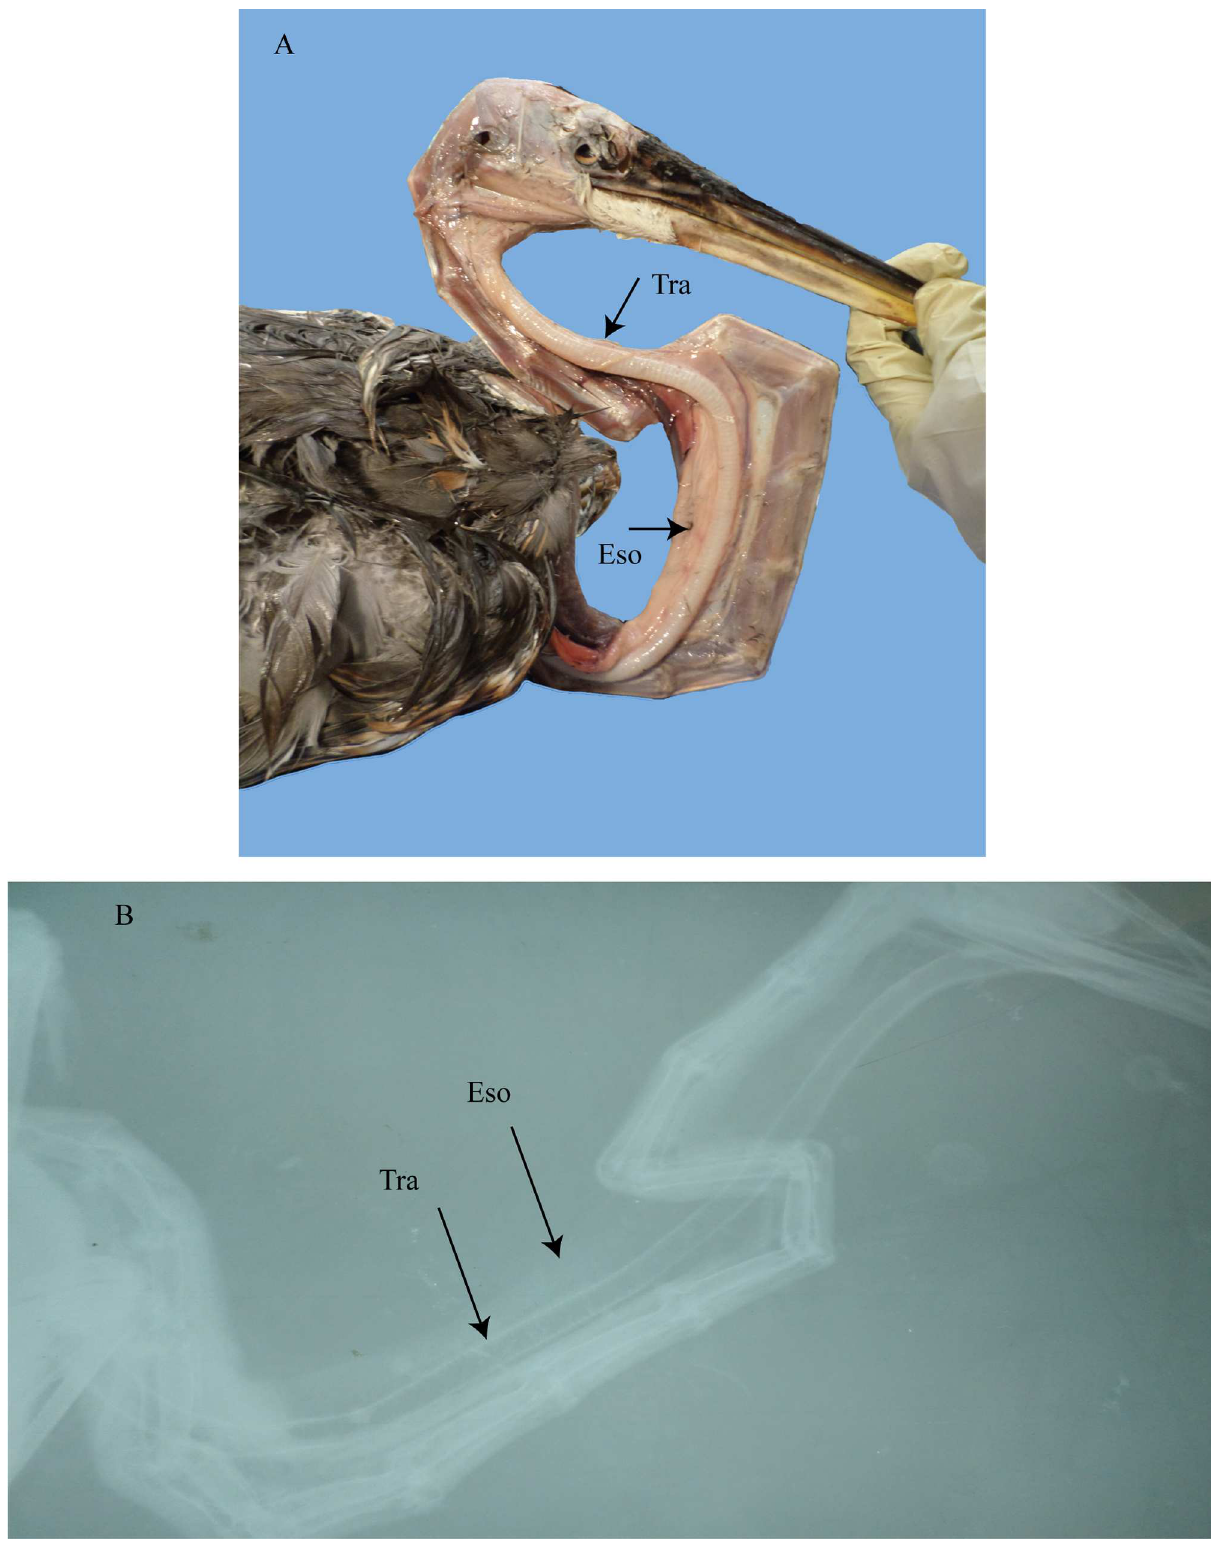
Fig 8. Ardea herodias . (A) dissection. (B) radiograph.Tra = trachea;Eso = esophagus.